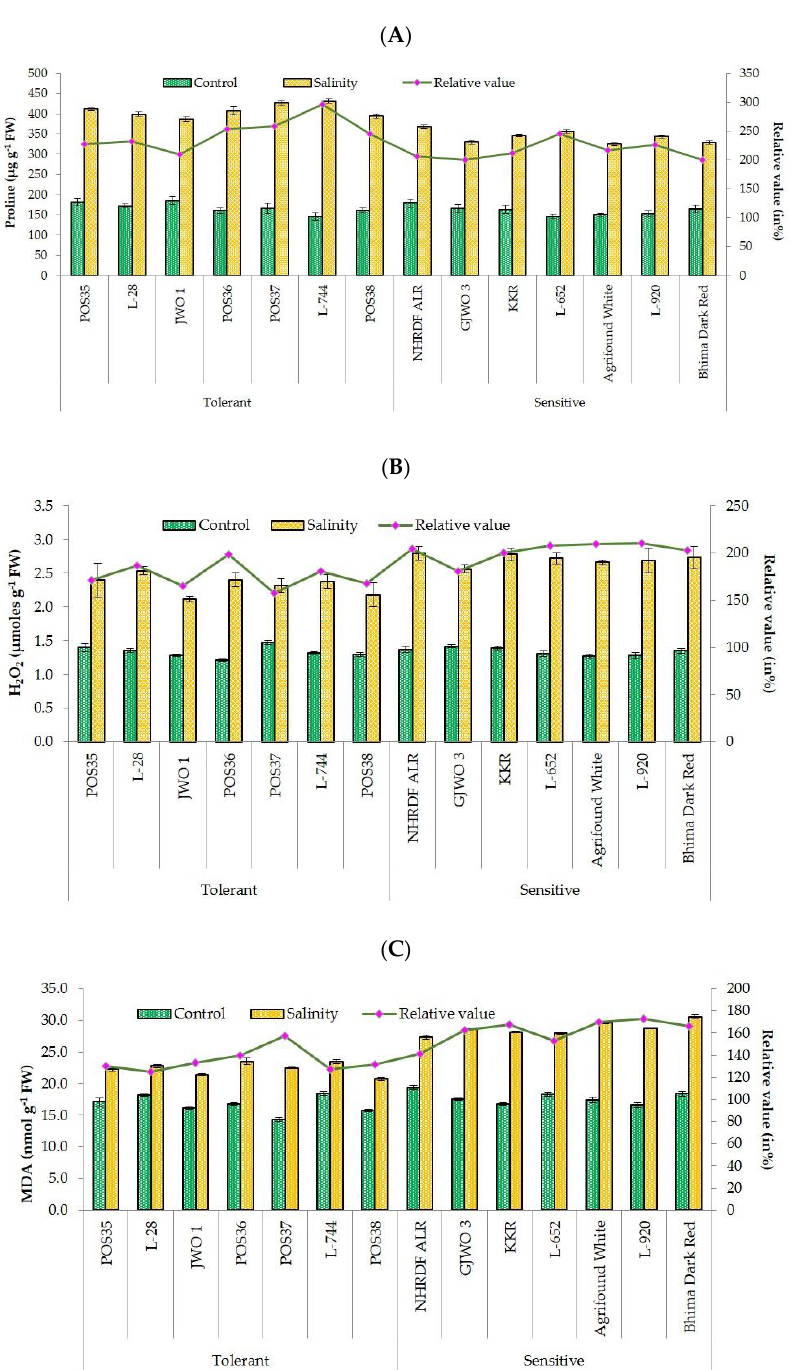
Figure 3. Alterations in biochemical parameters [Proline, ( A ); Hydrogen peroxide (H 2 O 2 ) ( B ); and Malondialdehyde (MDA) ( C )] of selected onion accessions under control and salinity stress.